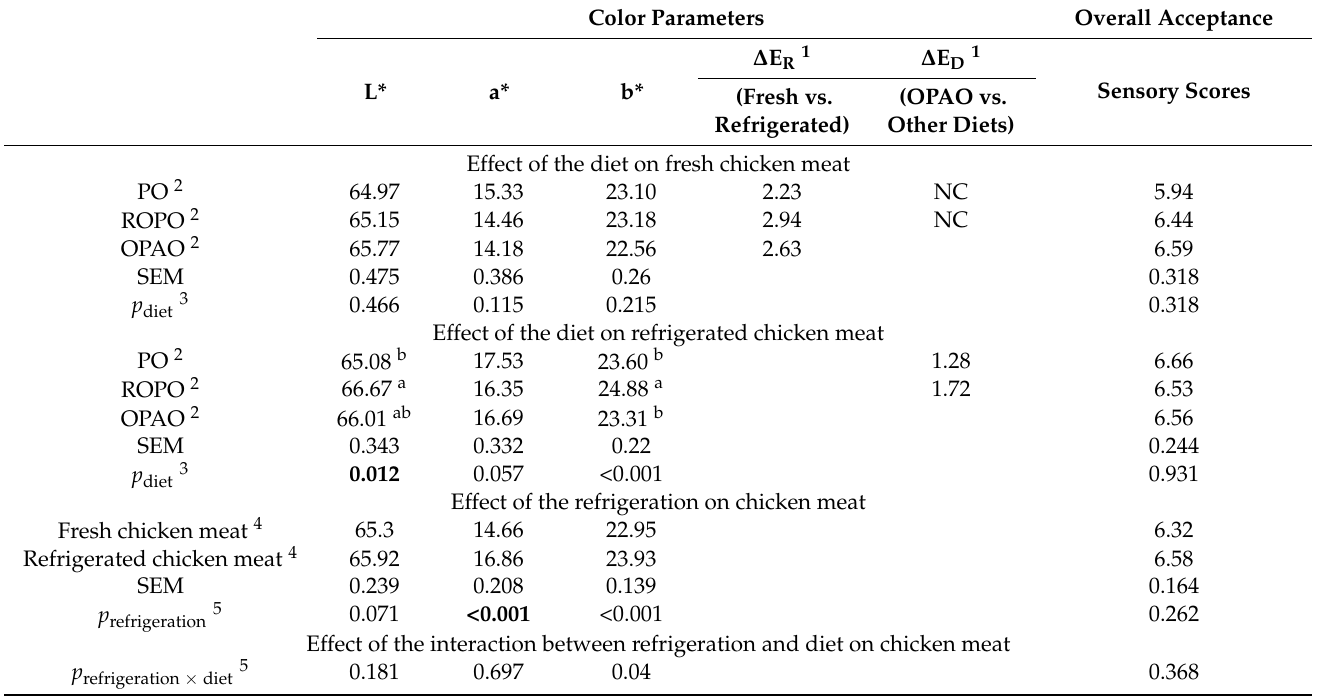
Table 7. Color parameters (L*, a*, b* instrumental parameters, ∆ E R , and ∆ E D ) and overall consumer acceptance of fresh and refrigerated dark chicken meat with